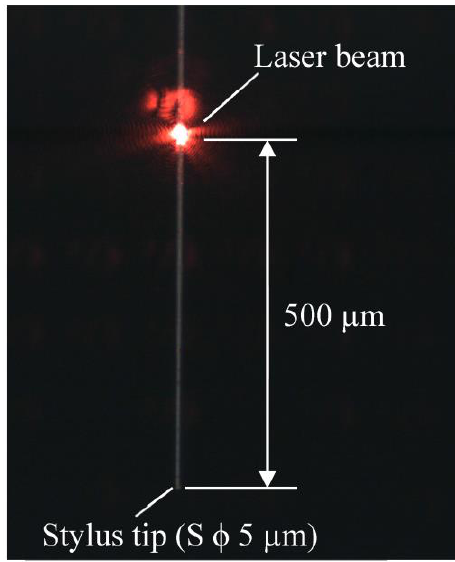
Figure 6. Photograph of the fiber stylus.